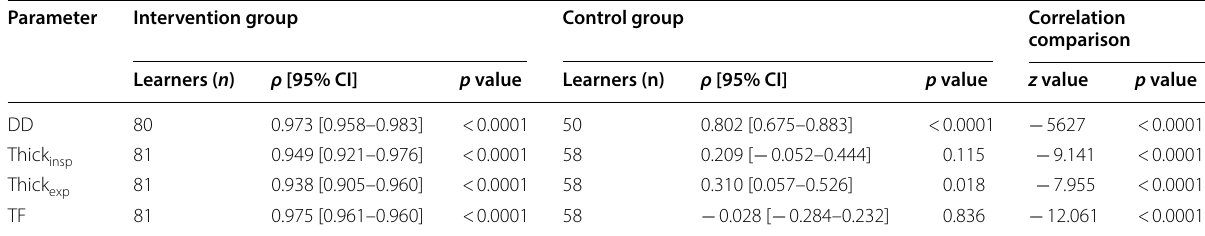
DUS, diaphragm ultrasound; ρ , correlation coefficient; 95% CI, 95% confidence interval; DD, diaphragm displacement; Thick insp , diaphragm thickness at inspiration;